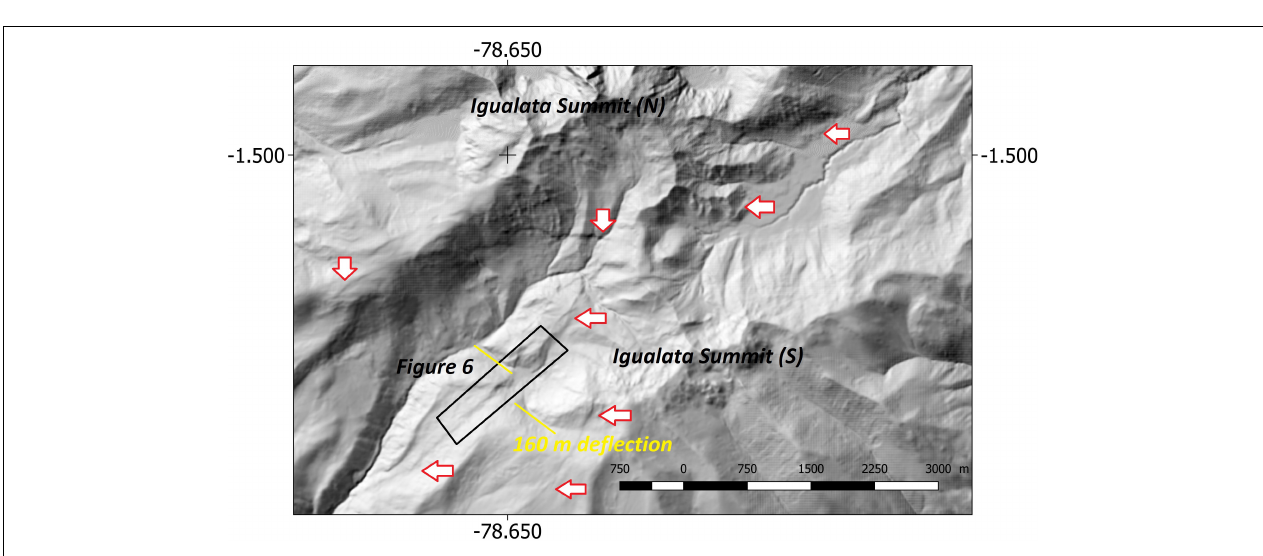
FIGURE 5 | Zoom-in of the Igualata center area. The figure highlights several sharp scarps and deflecting lineaments across the covered area, along the red arrows. The figure focuses on the lineament that includes the Figure 6 features and that seems to cause the 160 m right lateral deflection of the major incision (underlined in